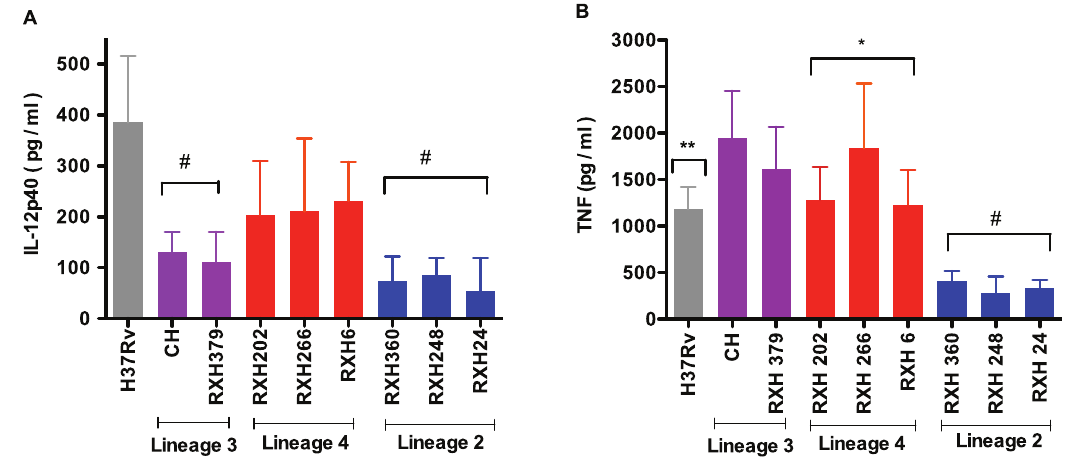
Figure 4. Cytokines detected in culture-supernatant (at 48 h) from MDM infected by different strains of M.tuberculosis . Fig. 4 (A) IL- 12p40 (n=6 donors). H37Rv and lineage 4 strains induced significantly higher level of IL-12p40 as compared to lineage 3 # and lineage 2 # lineages (p , 0.001 for both comparisons) Fig. 4 (B) TNF (n=8 donors). Lineage 3 strains induced significantly higher levels of TNF as compared to lineage 2 # (p=0.001), lineage 4* (p , 0.05) and H37Rv** (p=0.01). H37Rv and lineage 4 strains induced higher level of TNF than lineage 2 strain (lineage 4 vs lineage 2 p=0.001, H37Rv vs lineage 2 p=0.01). Data represent the median and range.